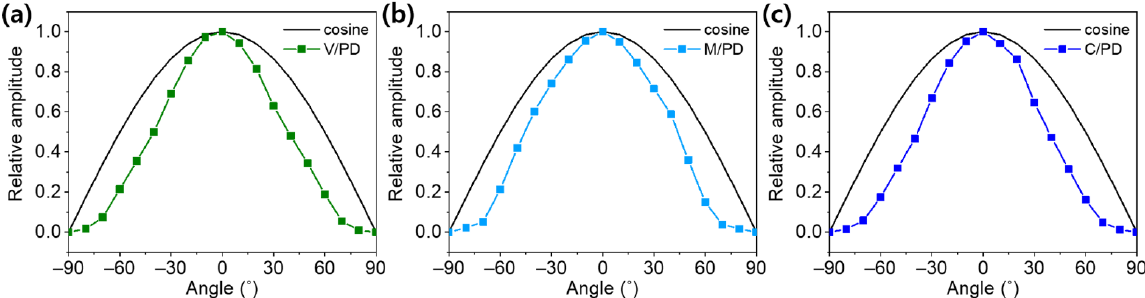
Figure 3. Spatial sensitivity of each channel of the circadian light meter. ( a ) V-filter attached photodiode for VIL measurement, ( b ) Mel-filter attached photodiode for melanopic EDI measurement, and ( c ) C-filter attached photodiode for CIL measurement.